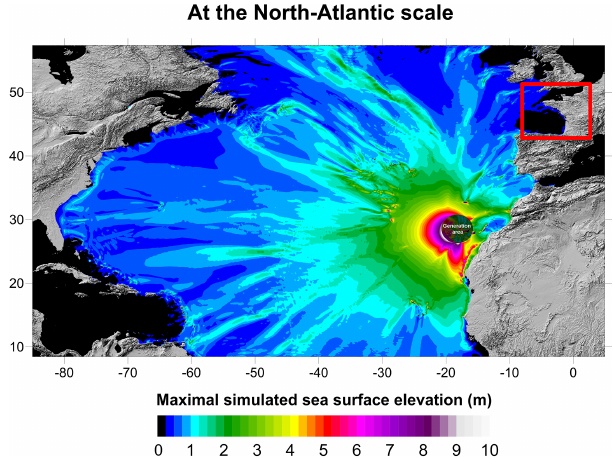
Figure 22. Maximum surface elevation computed with Calypso for the 80km 3 scenario using the finest grid resolution at isobath − 5m for different areas along the French Atlantic coastline: (a) Morbi- han, (b) Gironde estuary and (c) Saint-Jean-de-Luz